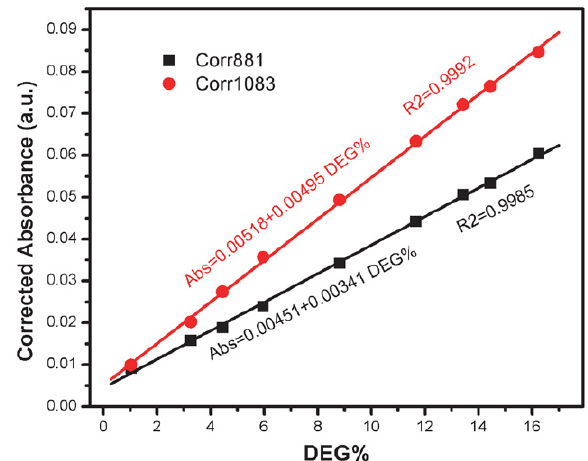
Figure 2: FT-IR spectra of Hederal unspiked and spiked with differ- ent DEG%.